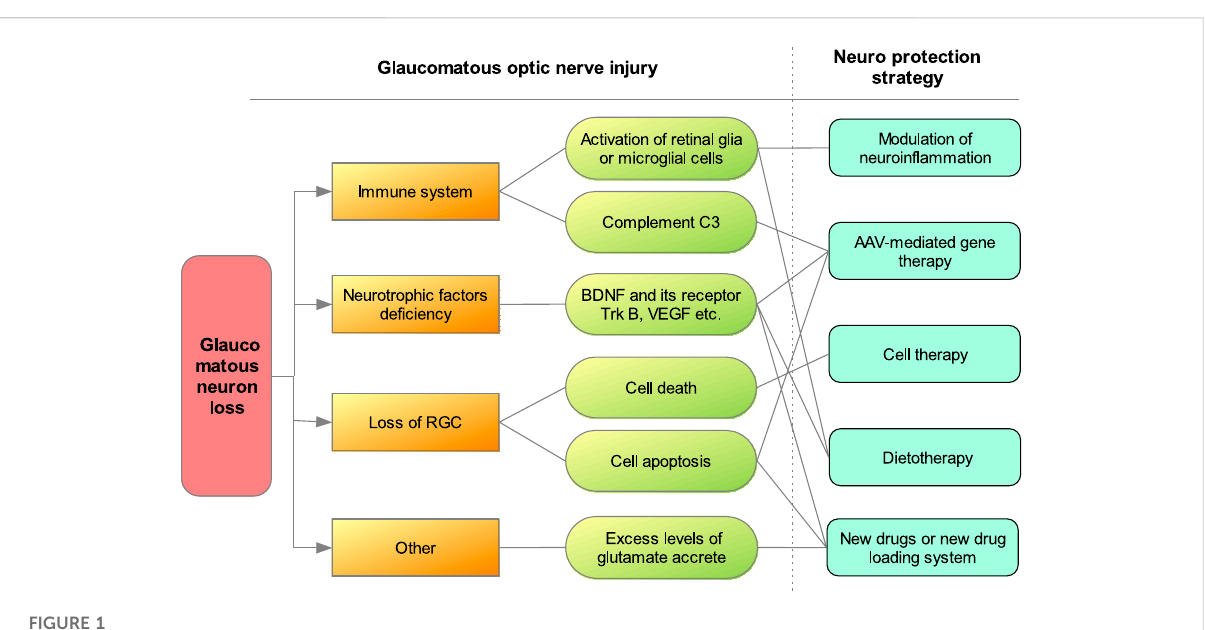
FIGURE 1 New neuroprotective strategy of glaucoma in recent 5